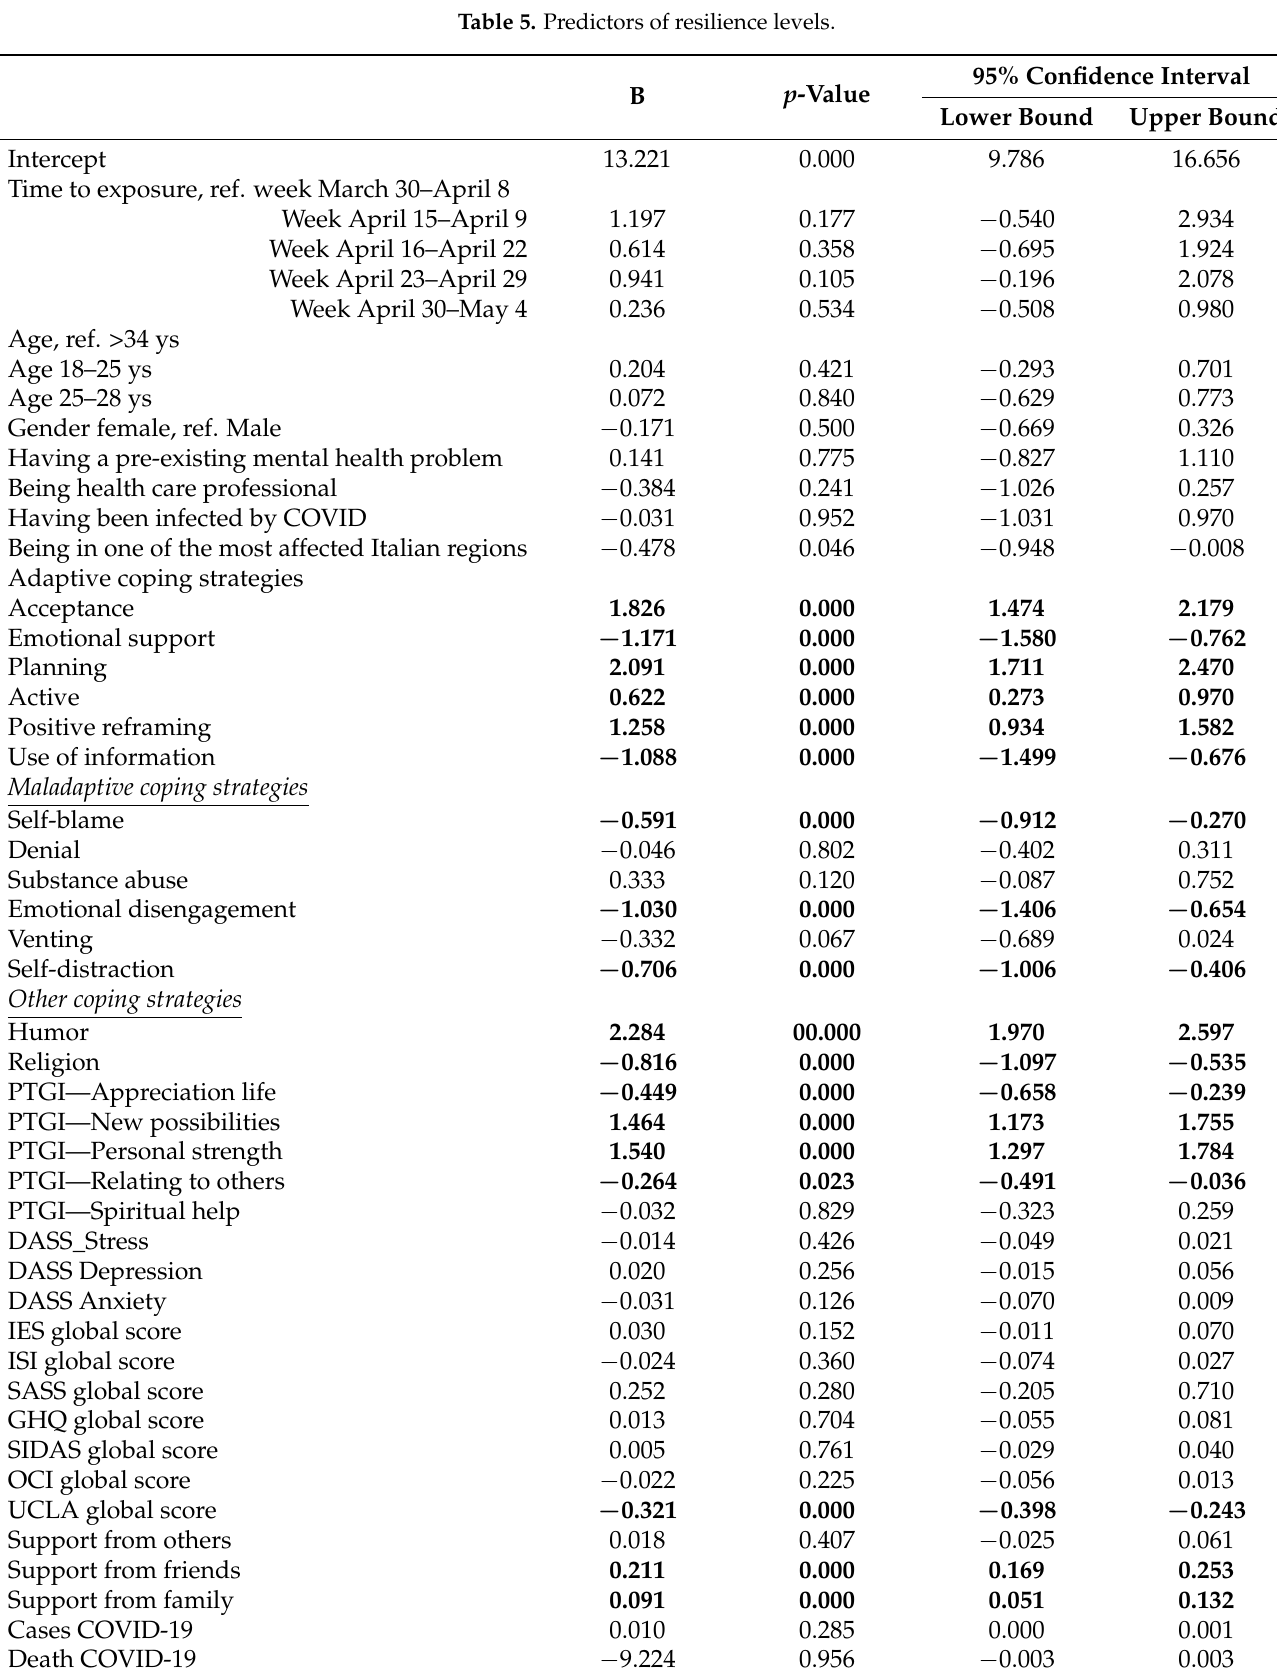
Table 5. Predictors of resilience